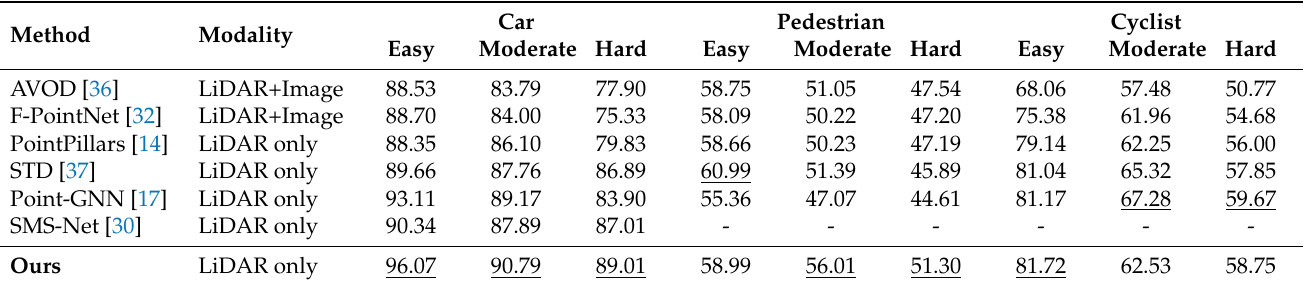
Table 2. The performance of 3D location performance AP BEV (%).